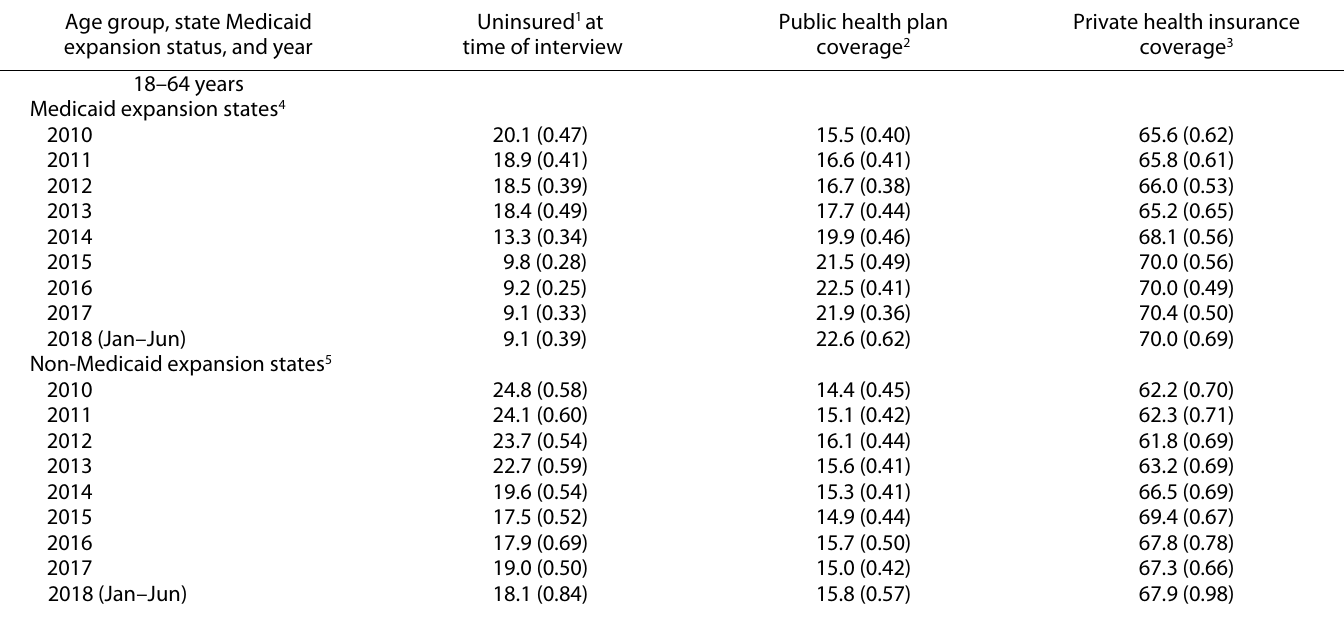
Table XIII. Percentages (and standard errors) of persons under age 65 who lacked health insurance coverage, had public health plan coverage, and had private health insurance coverage at the time of interview, by age group, state Medicaid expansion status, and year: United States, 2010–June